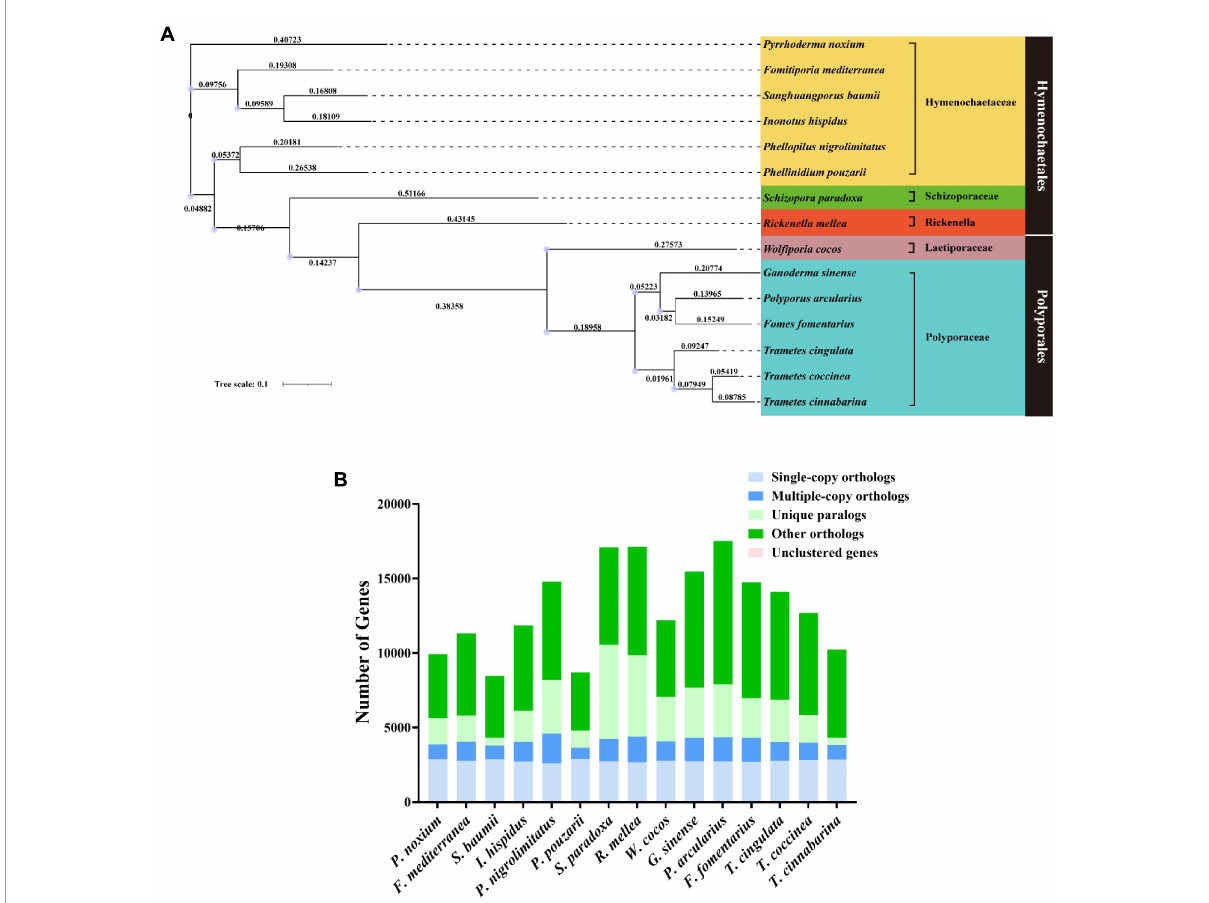
FIGURE9 Comparative genomic analysis of I. hispidus and other 14 fungi. (A) Phylogenetic tree of I. hispidus and 14 other fungal species. (B) Homologous genes of I. hispidus and 14 other fungi species.